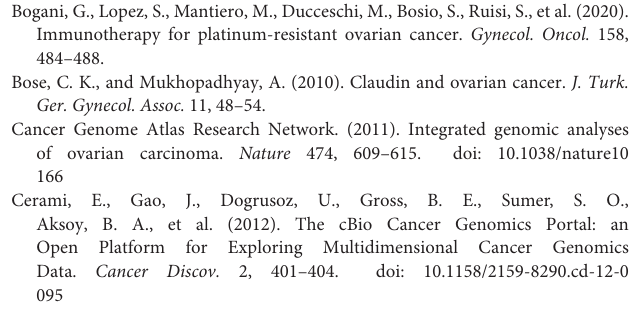
Supplementary Figure 1 | The significant unique analyses of claudins expression in ONCOMINE. (Red: overexpression; Blue: low expression). Supplementary Figure 2 | Associations between the expression of claudins and immune subtypes of ovarian cancer. Supplementary Figure 3 | Associations between the expression of claudins and molecular subtypes of ovarian cancer. Supplementary Figure 4 | The correlations between claudins (CLDN6 and CLDN10) expression and gene markers of immune cells across gynecologic oncology (Red: positive correlation; Blue: negative